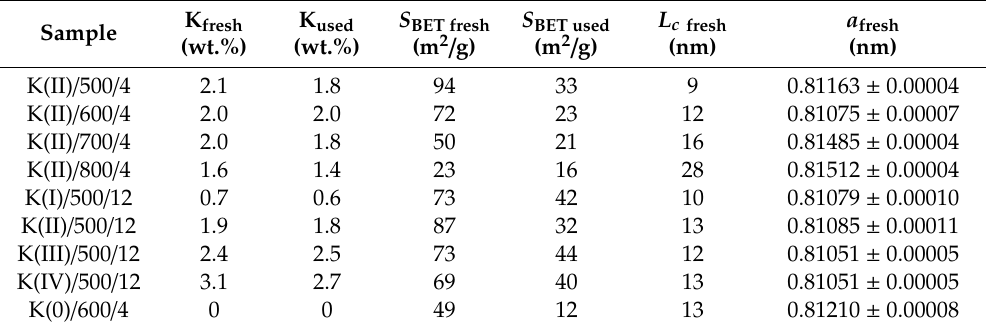
Table 2. Selected experimental parameters (K content, specific surface area, particle size and unit cell parameter) for the investigated fresh and used catalysts. K fresh Sample